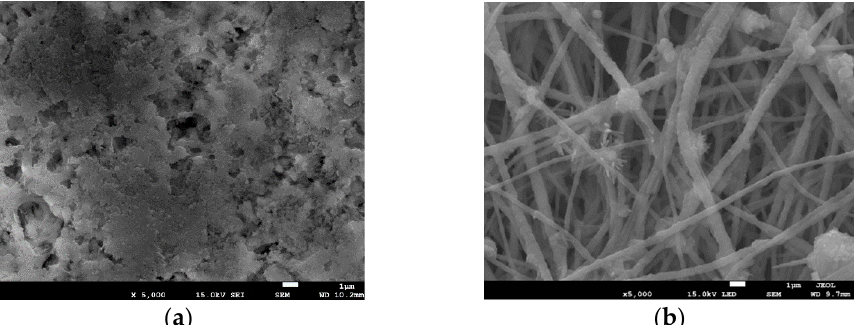
Figure 9. Scanning electron micrograph of Ca 2+ –Mg 2+ /SDS fouled membranes: ( a ) PVDF-H, ( b ) PVDF-O